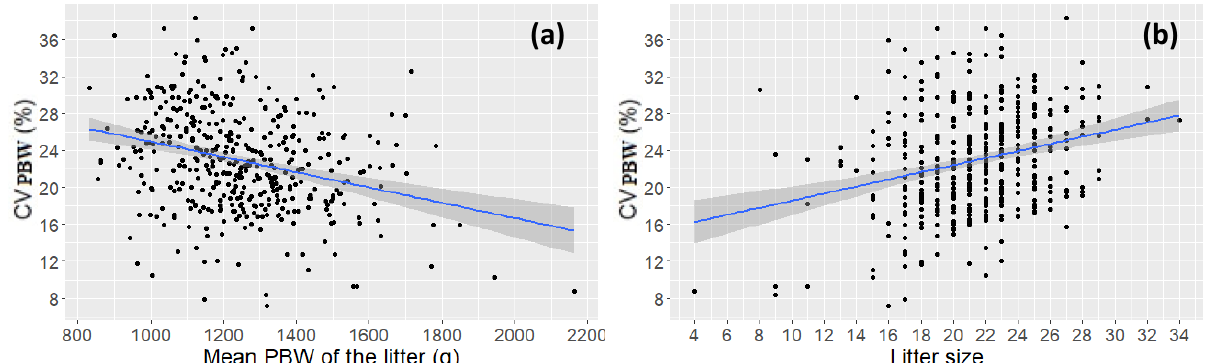
Figure 3. Relationship between ( a ) mean piglet birth weight (PBW) of the litter and within-litter percentage of PBW (CV PBW ) across parities (n = 451). The fitted regression: CV PBWi % = 33.22 − 0.0083 * MeanPBW i +, ε ~N(0, 5.131 2 ). The correlation was − 0.286 ( p < 0.001), and ( b ) litter size and CV PBW across parities (n = 451). The fitted regression: CV PBWi % = 17.34854 + 0.38800 * LS i + ε i , ε ~N(0, 5.14 2 ). The correlation was 0.265 ( p <